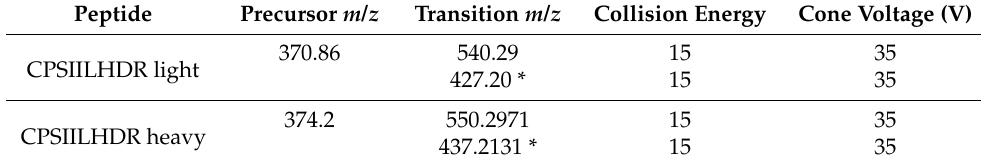
Table 2. Optimized parameters for PCYOX1 analysis by mass spectrometry. Peptide Precursor m / z Transition m / z Collision Energy Cone Voltage (V) 370.86 540.29 15 35 CPSIILHDR light 427.20 * 15 35 374.2 550.2971 15 35 CPSIILHDR heavy 437.2131 * 15